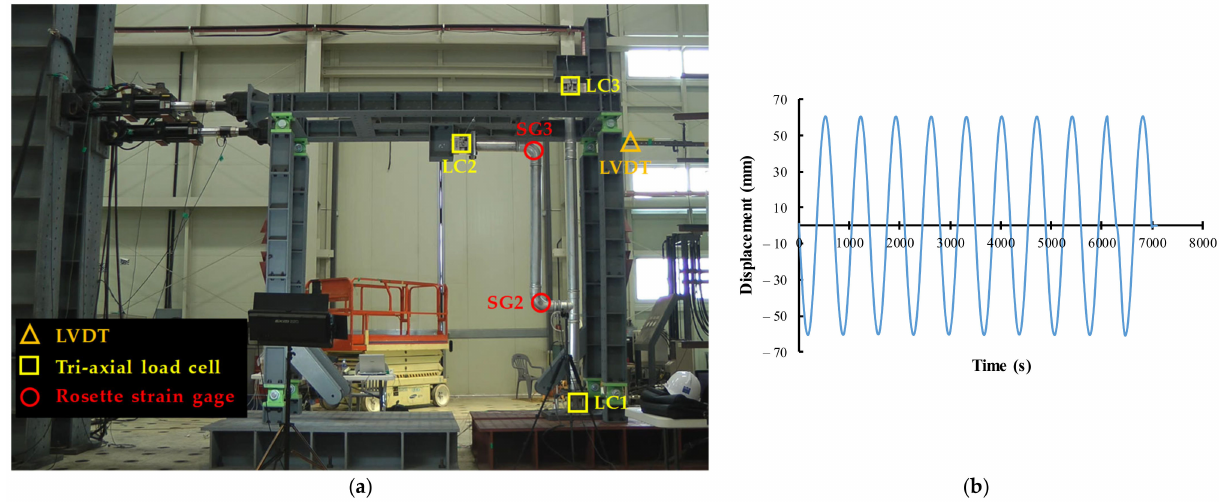
Figure 8. Test setup of a large-scale press-to-connect piping system: ( a ) experimental set up; ( b ) cyclic loading protocol.